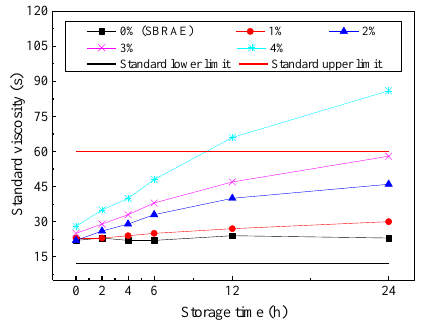
Figure 3. Viscosity variation values for the WESAE and SBRAE.